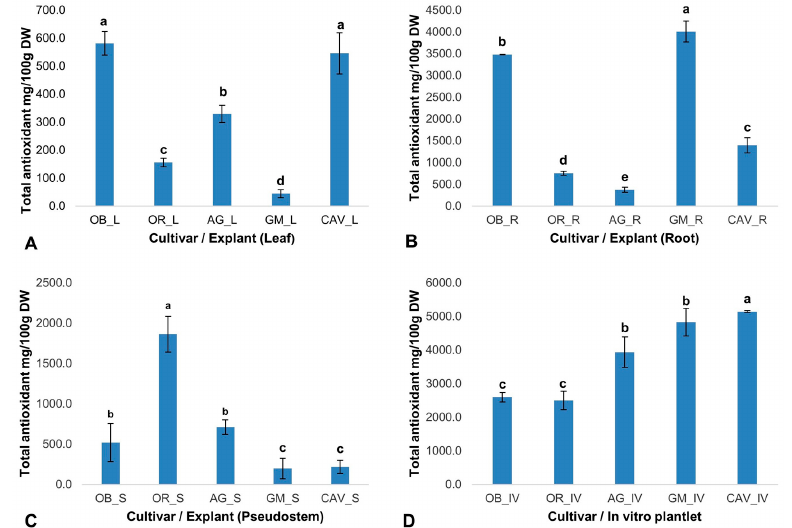
Figure 1. Total antioxidant activity in various explants of field-grown plants and in vitro plantlets of different cultivars of banana and plantain. (A) Leaf (L) explant; (B) Root (R) explant; (C) Pseudostem (S) explant; (D) In vitro (IV) plantlet. Each bar represents the mean of triplicate samples ( n ≥ 3), and the error line indicates the standard deviation. Means with a different letter (a–e) significantly from each other at p ≤ 0.05. OB—Obino l’Ewai; OR—Orishele; AG—Agbagba; GM—Gonja Manjaya; CAV—Cavendish Williams; DW—Dry weight of sample.